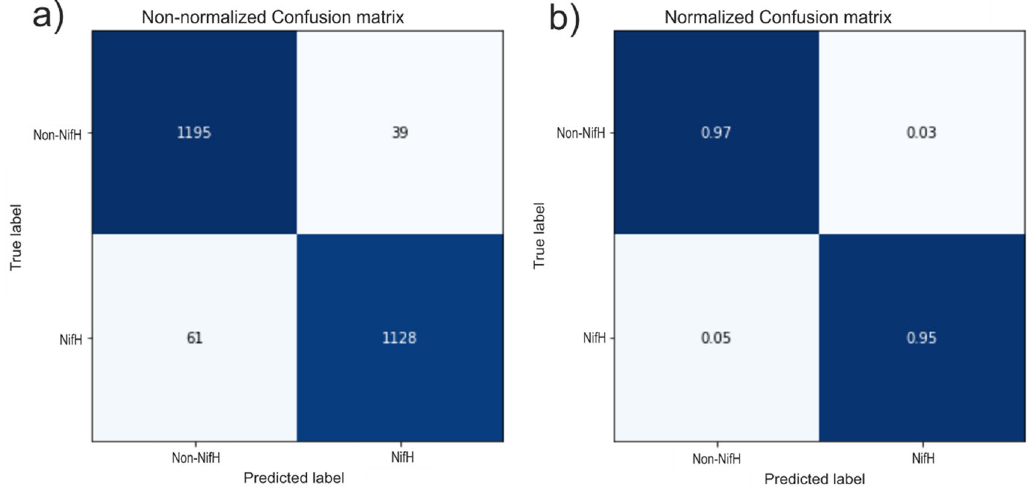
Figure 8. Assessment of the efficiency of the Deep Neural Network by a Confusion matrix. a) Panel a shows the confusion matrix for the number of evaluated sequences, and panel b corresponds to the number of evaluated sequences normalized to one. TP: true positive =1188, TN: true negative = 1132, FP: false positive = 25, and FN: false negative =